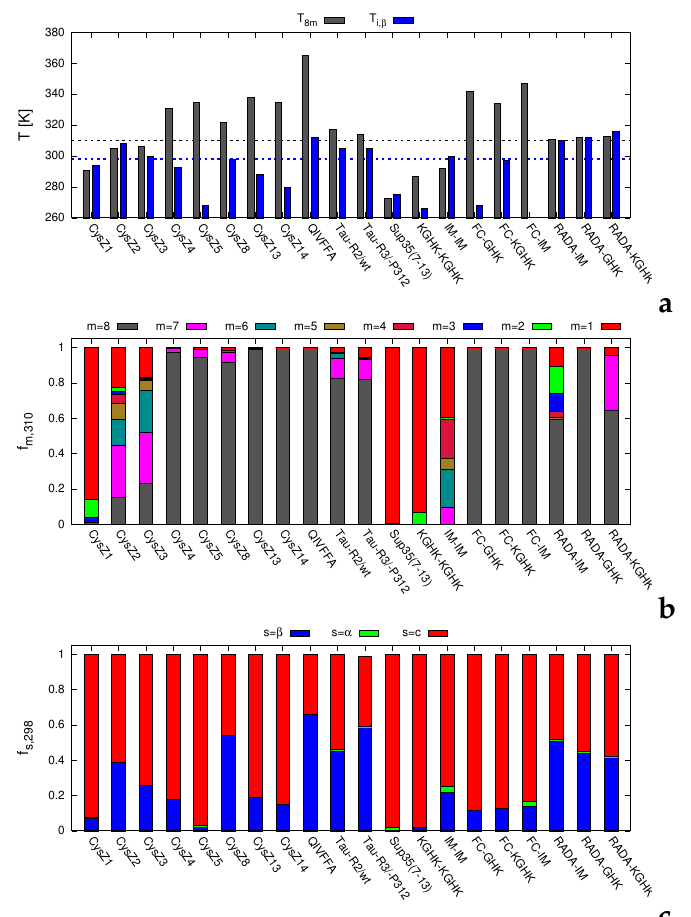
Figure 3. ( a ) Bar plot of the octamer half-melting temperatures ( T 8 m ) and the temperatures at which the temperature dependence of the fraction of β -structure has an inflection point ( T i , β ). The dashed horizontal black and blue lines correspond to the incubation (310 K) and the room (298 K) temperatures, respectively. ( b ) Stacked-histogram plot of the fractions of the monomer and the oligomers. ( c ) Stacked-histogram plot of the fractions of β , α and coil structures for all peptides studied. The graphs were drawn with gnuplot